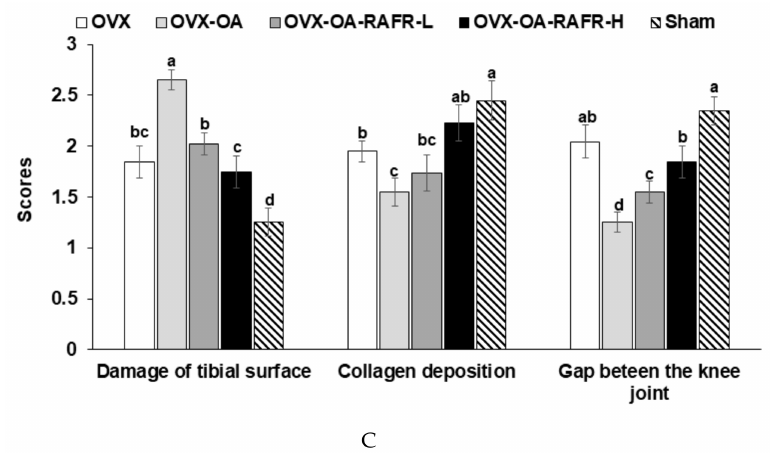
Figure 6. The histopathological features of osteoarthritic lesions in the knee joints of rats after 21 days of intra-articular injection of monoiodoacetate (MIA) Ovariectomized (OVX) rats were divided into four groups: (1) MIA injection into the knee joint and fed a high-fat diet containing 0.23% rice + 0.018% AFR diet (RAFR-L). (2) MIA injection into the knee joint and fed a high-fat diet containing 0.69% rice + 0.053% AFR diet (RAFR-H). (3) MIA injection into the knee joint and fed a high-fat diet added 0.053% cellulose (OA-control). (4) saline injection into the knee joint and fed a high-fat diet containing 0.053% cellulose (non-OA control). Sham rats had the same diet as the control and received a saline injection (normal-control). At the beginning of the eighth week, an articular injection of monoiodoacetate into the right knee was performed in all OVX groups except the normal-control group, and the assigned diets were provided for an additional three weeks. The depth and extent of cartilage damage and the quantification of the damage were determined in hematoxylin-eosin stained ( A ), para ffi n-embedded knee joint sections from MIA-injected rats (magnifying power × 10). The depth and extent of cartilage damage and quantification of the cartilage damage in the MIA-injected knees were evaluated in Safranin O–fast green–stained ( B ) knee joint sections from the osteoarthritic rats (magnifying power × 2.5). Scores of the knee joint damage ( C ) were calculated from the stained sections. Each bar and error bar represents the mean ± SD ( n = 5). a,b,c,d Values of the bars with di ff erent superscripts were significantly di ff erent among groups as per the Tukey test at p <